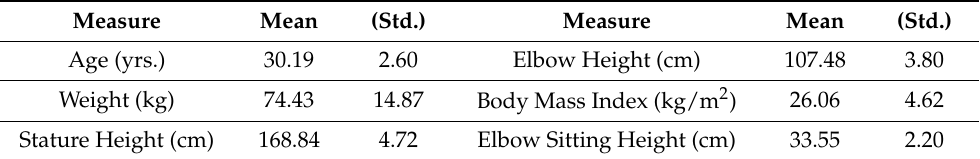
Table 1. Detailed information on the